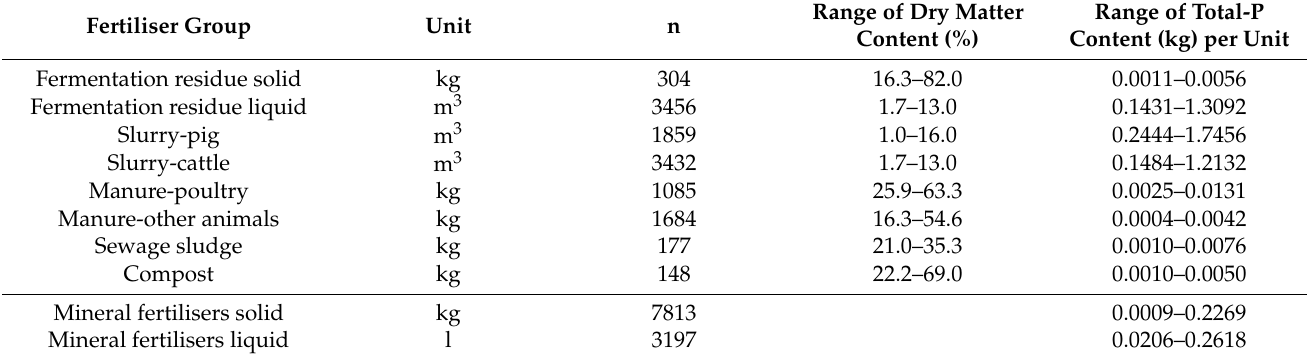
Table 2. The main organic and mineral phosphorus (P) fertilisers used. n = number of applications in the full study sample. Range of dry matter content (%) and total-P content (kg) in the fertiliser groups. The fermentation residues are the products of anaerobic